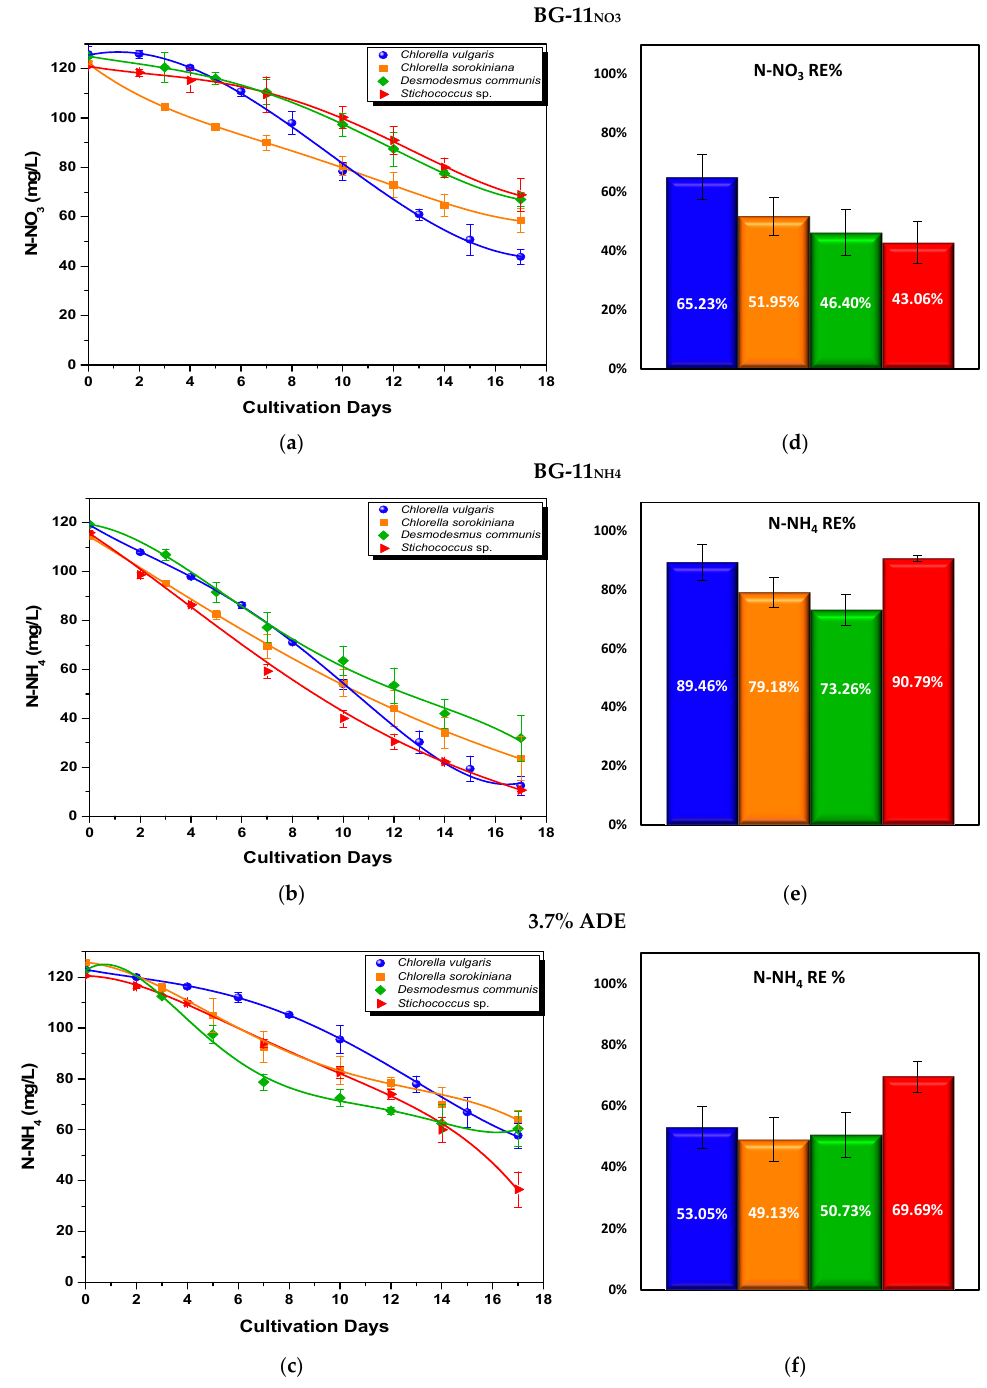
Figure 4. Nitrogen concentration in the three different media by microalgae ( a – c ) and nitrogen RE at the end of the culture period ( d – f ) of the four microalgae species in the three different media: C. vulgaris , orange bar: C. sorokiniana , green bar: D. communis and red bar: Stichococcus sp. Successful growth of the 4 microalgae species was observed in 3.7% ADE. The growth curve and the final biomass of the four microalgae species is presented in Figure 2c,f and Ta- ble S1. These data are further supported by cells number significant incensement at the